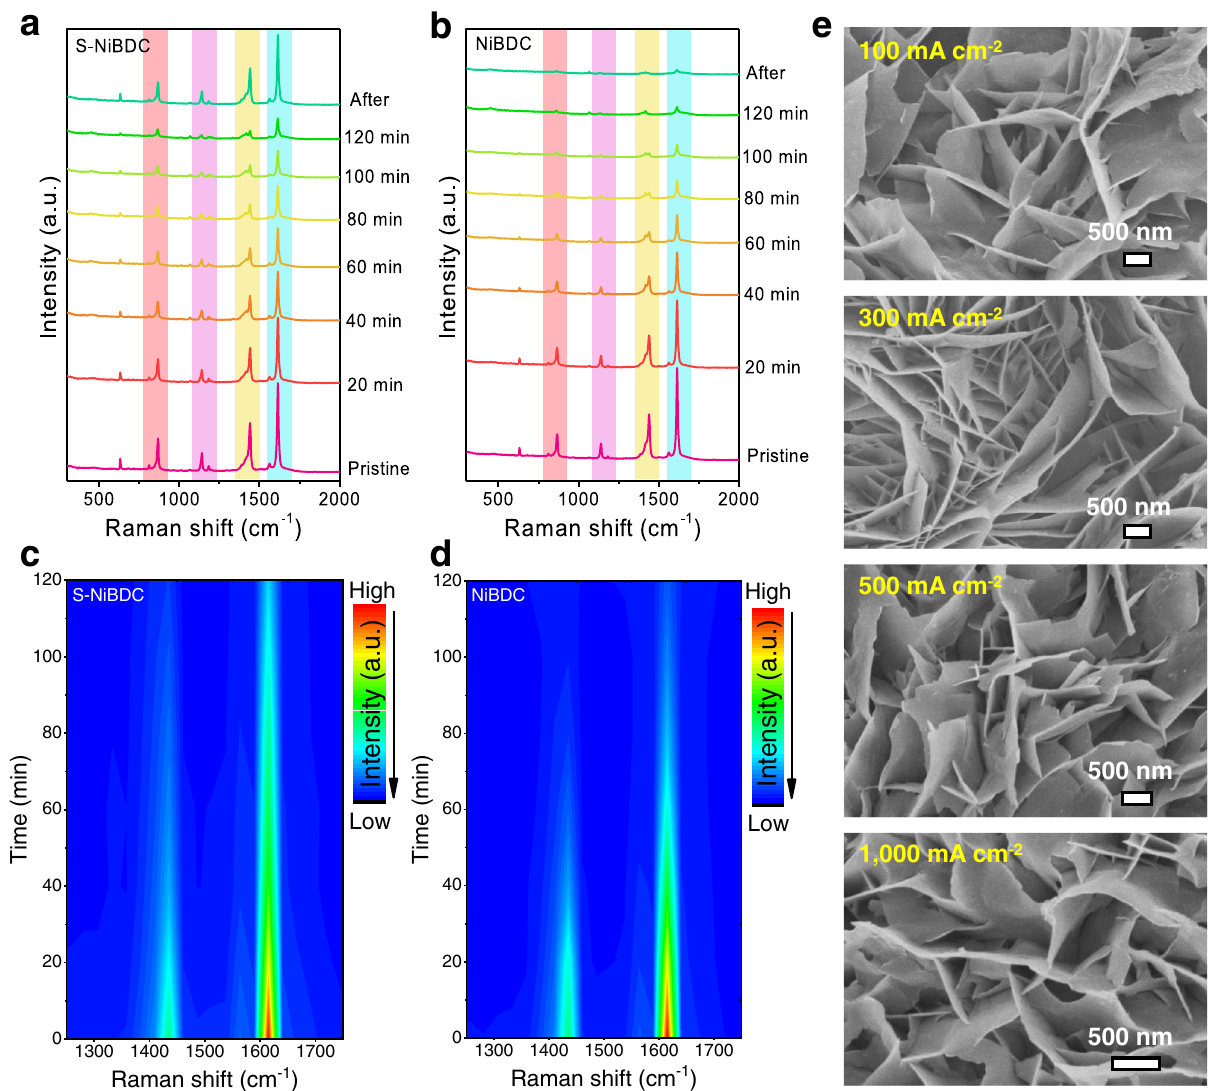
Fig. 4 | Enhanced structural stability identi fi ed by In-situ Raman spectra and FESEM imaging. a – d In-situ Raman spectra and corresponding contour plots of